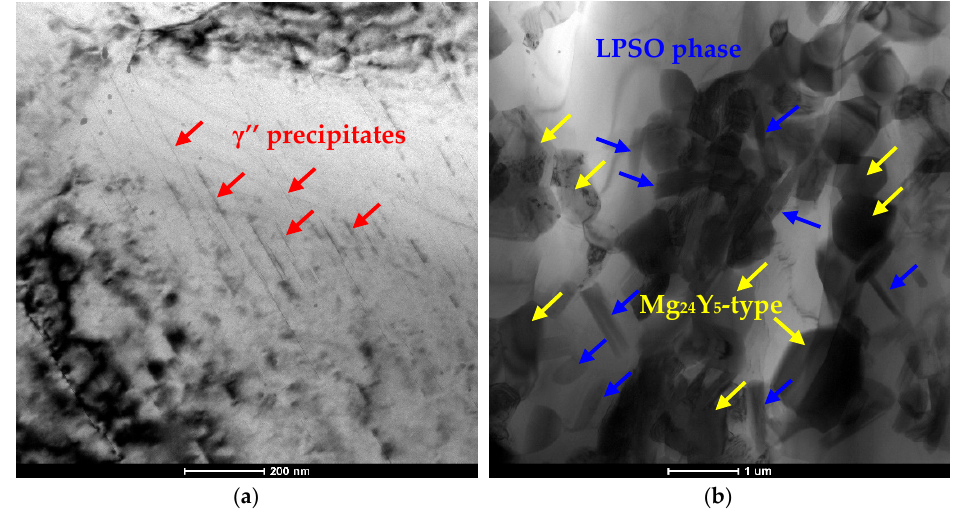
Figure 9. TEM images of T5 peak aged Mg-10Y-6Gd-1.5Zn-0.5Zr alloy. ( a ) Nanosized acicular γ ’’ precipitates in α -Mg grain; ( b ) Morphology of second phase lamellae.